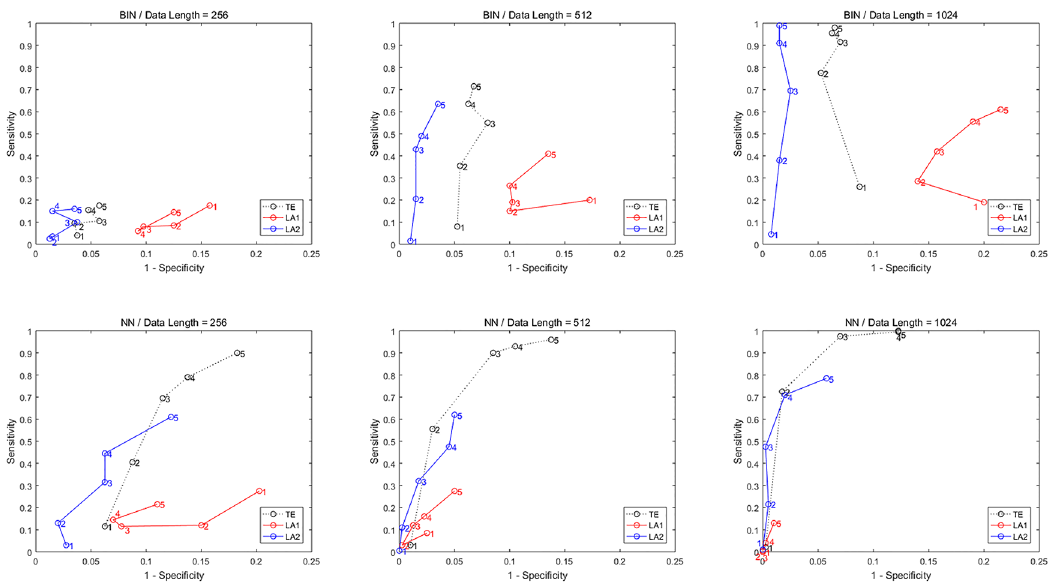
Fig 13. ROC curves for Model G with different data lengths and coupling strengths. Sensitivity and specificity are obtained from three coupled Lorenz oscillators with data length from 256 to 1024 and coupling strength (marked in the figure) from 1 to 5. The first row shows results from the methods applying binning estimator and second row for NN estimator. Column 1 to 3 is with data length from 256 to 1024. Each simulation was performed by 100 runs.